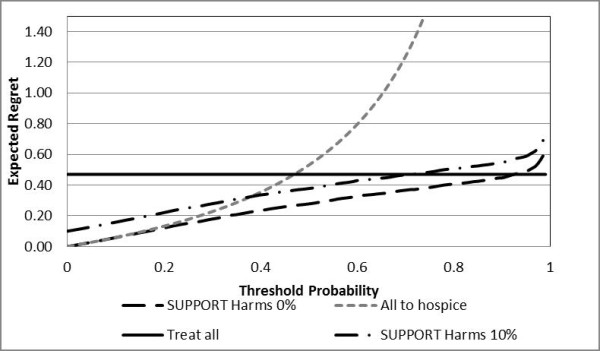
Decision curves as a function of Hte. In this figure, RRRHosp = 0, RRRRx = 0, HRx = HHosp = 0 and Hte = 0% and 10%. As the harms associated to the prediction test increase, so does the expected regret of utilizing the SUPPORT model for hospice referral. Increasing the harms due to treatment or due to hospice care does not have an effect on the decision curves.